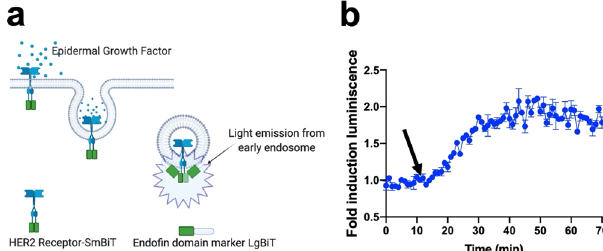
Fig. 5 Real time monitoring of internalization of a prototypical non-GPCR. a Schematic representation for monitoring internalization of a non-GPCR, the HER2 receptor. b HER2 receptor time course internalization of cells expressing the receptor treated with 10 µ M ( fi nal concentration) human epidermal growth factor (hEGF). The arrow indicates the time when the cells were treated with the virus. The results are expressed as mean ± s.e.m. of three experiments performed in triplicate; each triplicate was averaged before calculating the s.e.m. The corresponding Z ’ factor was